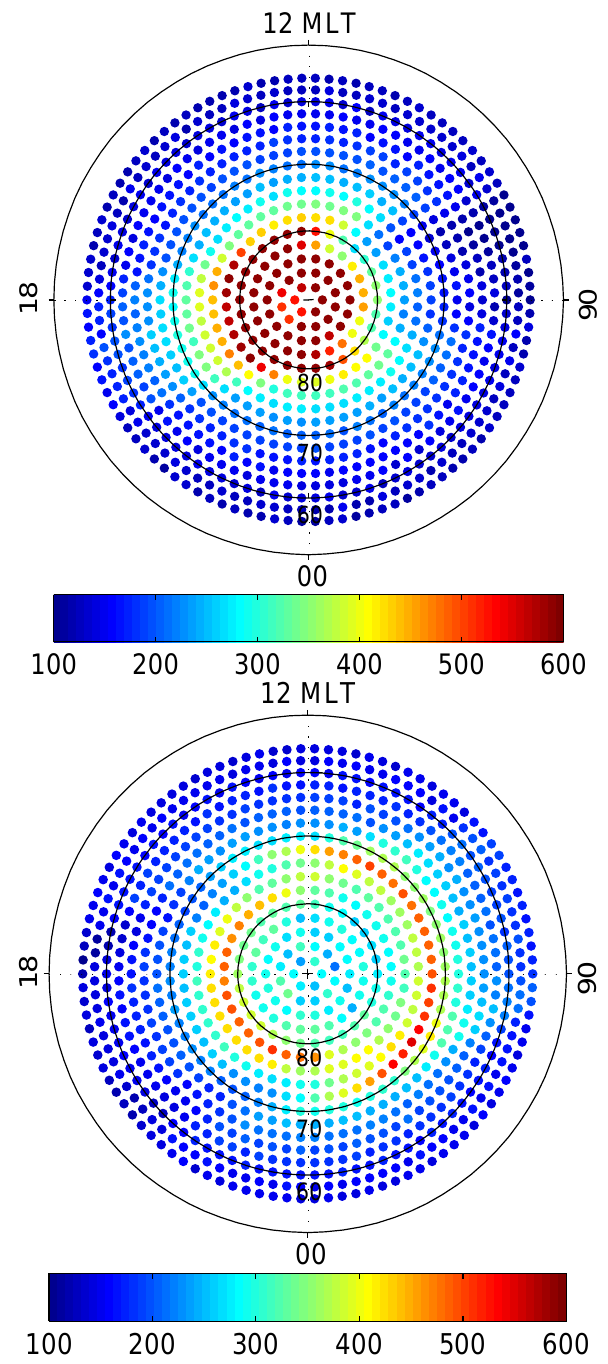
Fig. 2. Distribution of sample number per bin for the Northern (top) and Southern (bottom) Hemisphere. In the north a high sample fre- quency of 600 per bin is attained within the polar cap, reducing to 100 at sub-auroral latitudes. In the Southern Hemisphere the sam- ples are distributed more